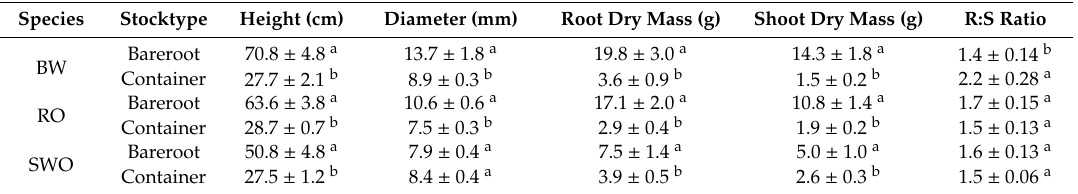
Table 1. Pre-planting seedling morphological measurements.